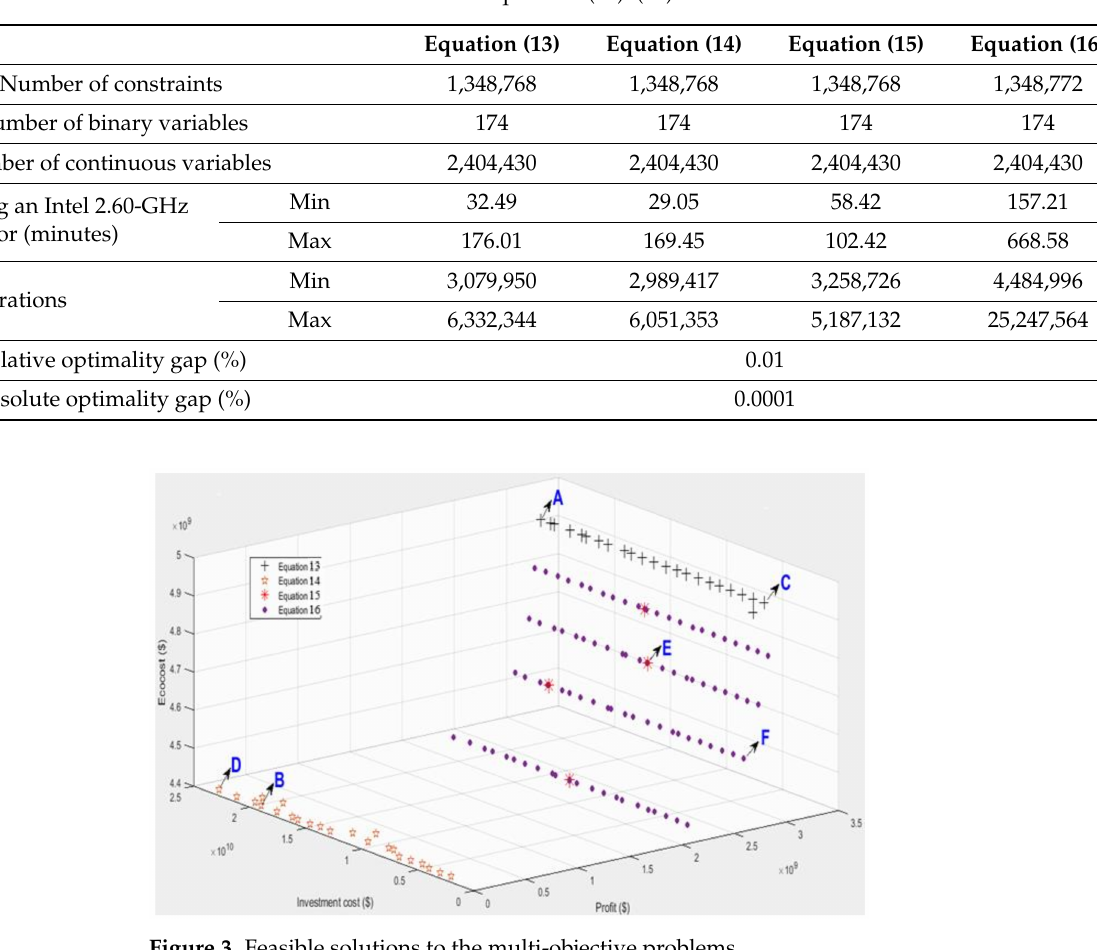
Table 6. Statistics for Equations (13)–(16).